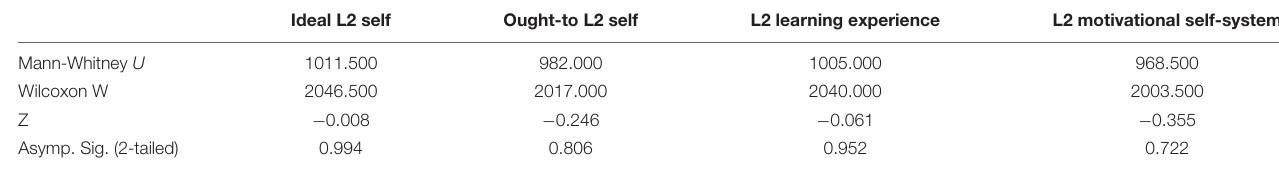
TABLE 2 | The results of the Mann-Whitney U- tests for L2 motivational self-system and its attributes. Ideal L2 self Ought-to L2 self L2 learning